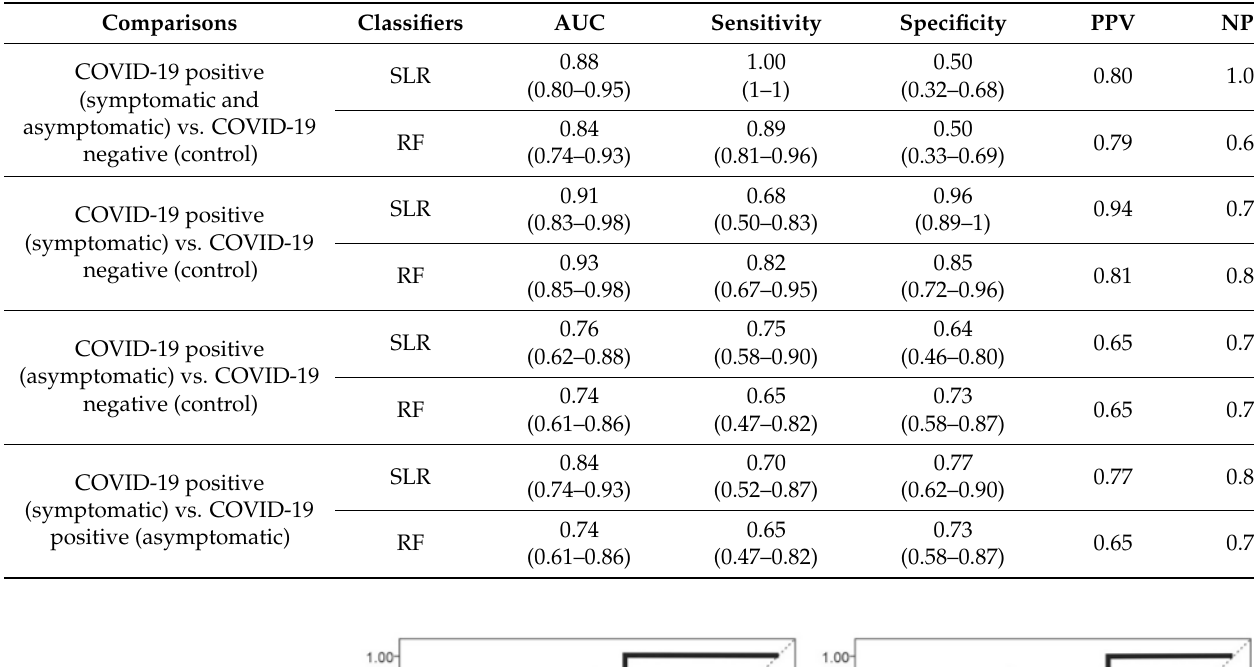
Table 3. Statistical results comparing different patient groups using individual chemicals.